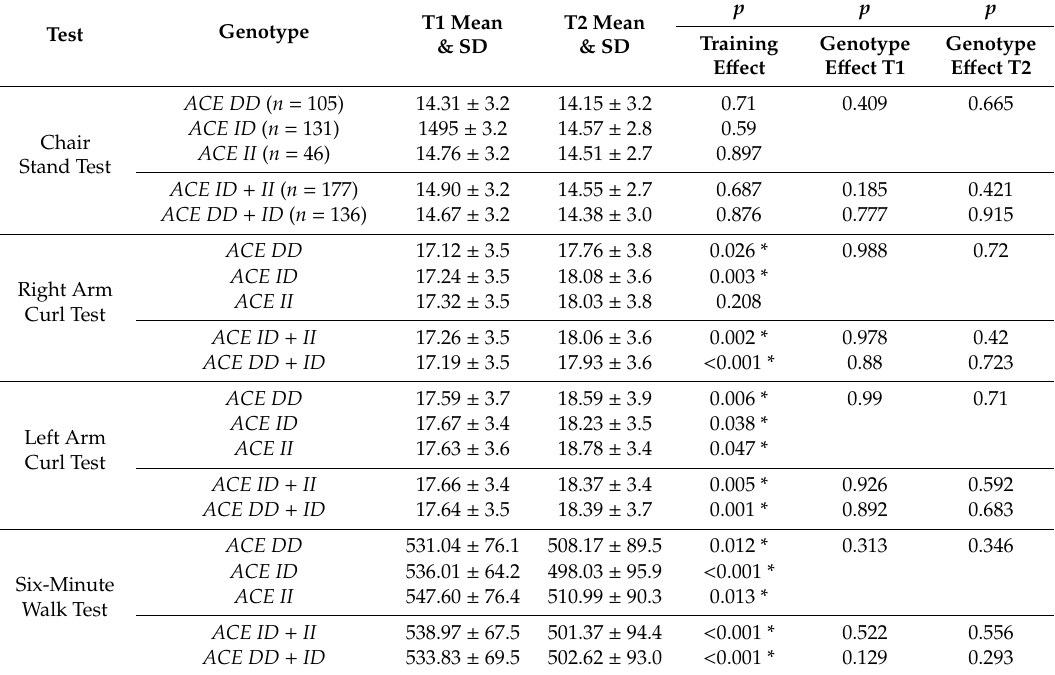
Table 1. Physical tests at baseline and after training and its association with training and ACE